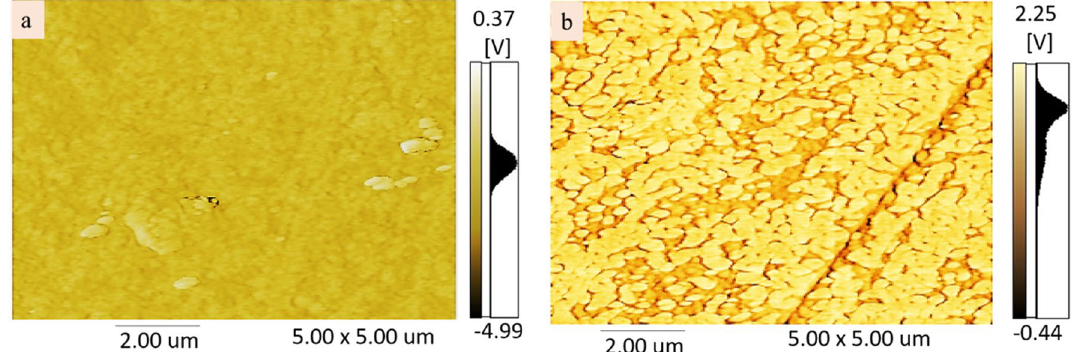
Figure 1. AFM phase images of PEDOT:PSS films without ( a ) and with isopropanol treatment ( b ). All images are 5 µm × 5 µm.